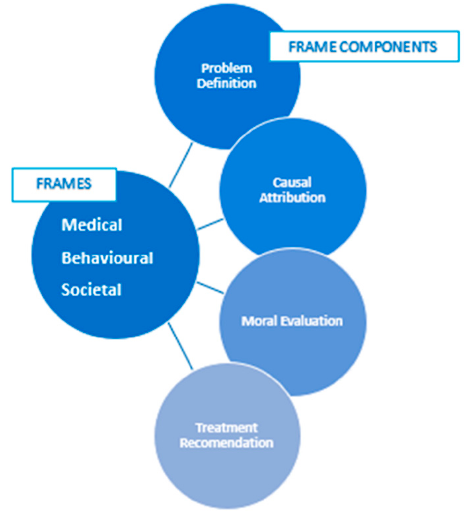
Figure 2. Frames and frame components included in framing analysis.